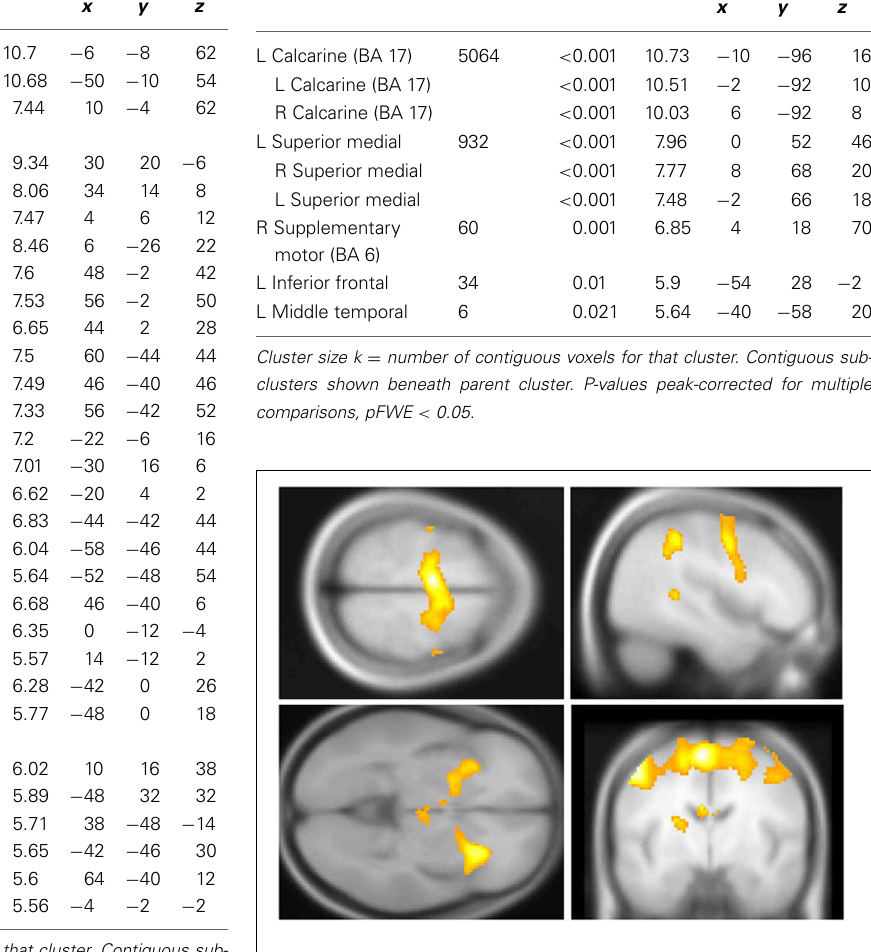
FIGURE 3 | Central executive and salience network BOLD responses to correct stop trials vs. baseline. Significant activations throughout the motor control and salience networks, including premotor/supplementary motor area ( top left and right ), anterior insula ( bottom left ), putamen, ( bottom left ) and middle frontal gyrus ( top right ) BOLD activations to correct stop trials, shown in yellow. Voxel-wise statistical parametric maps (pFWE < 0.05, k threshold > 5 contiguous voxels) superimposed on SPM canonical anatomical image, average of 305 T1-weighted images. Top left shown at MNI Z = 62, top right at X = 47, bottom left at Z = − 3, bottom right at Y = − 8. See Table 3 for a complete list of